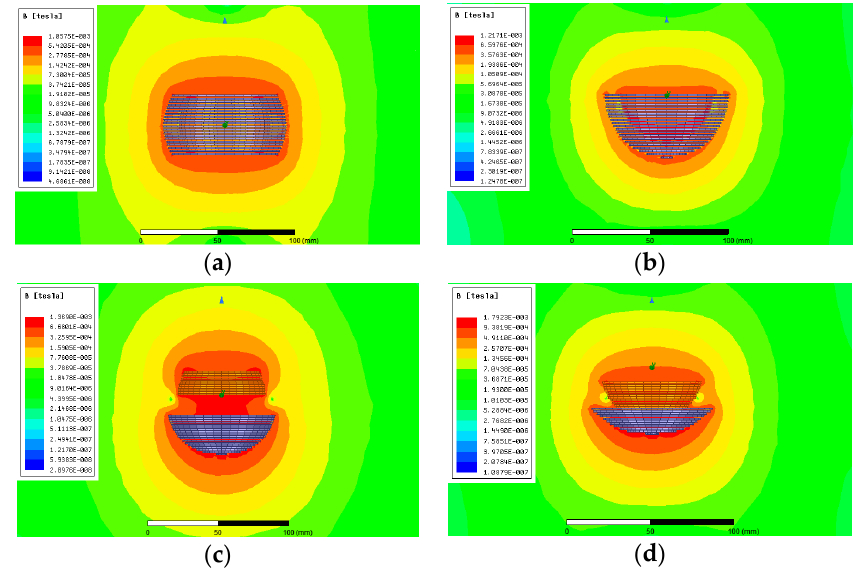
Figure 14. The magnetic field density: ( a ) equator windings; ( b ) hemisphere windings; ( c ) double- layer windings; ( d ) modified hemisphere windings. windings; ( d ) modified hemisphere windings.